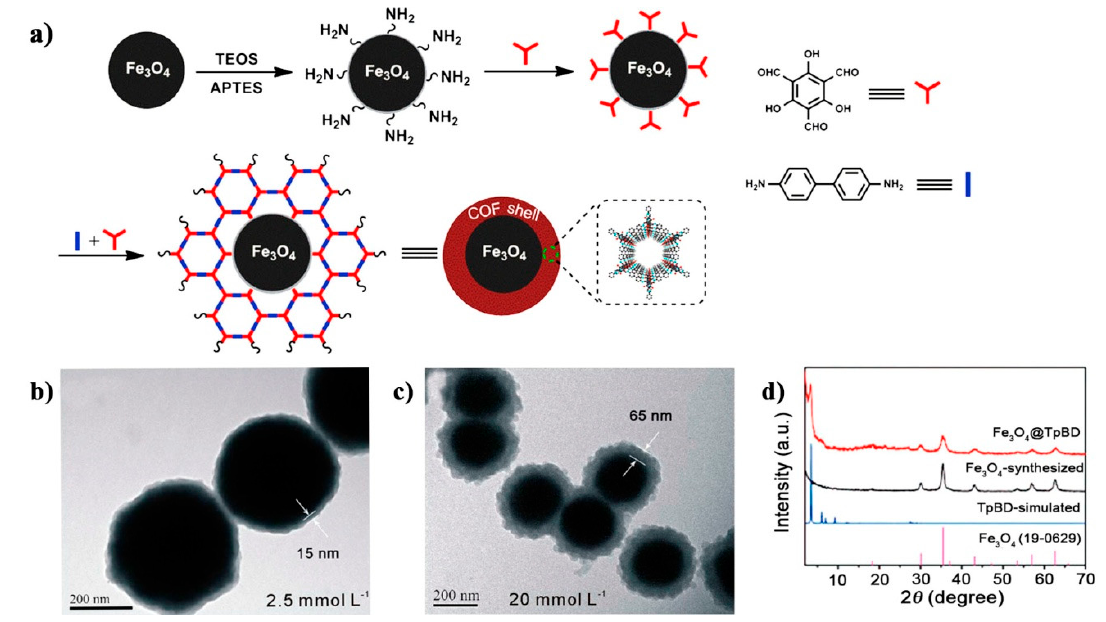
Figure 4. ( a ) Illustration of the monomer-mediated in situ growth of core − shell Fe 3 O 4 @TpBD. ( b,c ) TEM images of the monomer concentration effect on Fe 3 O 4 @TpBD. ( d ) The XRD patterns of Fe 3 O 4 @TpBD, Fe 3 O 4 , and simulated TpBD. Reproduced from [23] with permission from The Royal Society of Chemistry.